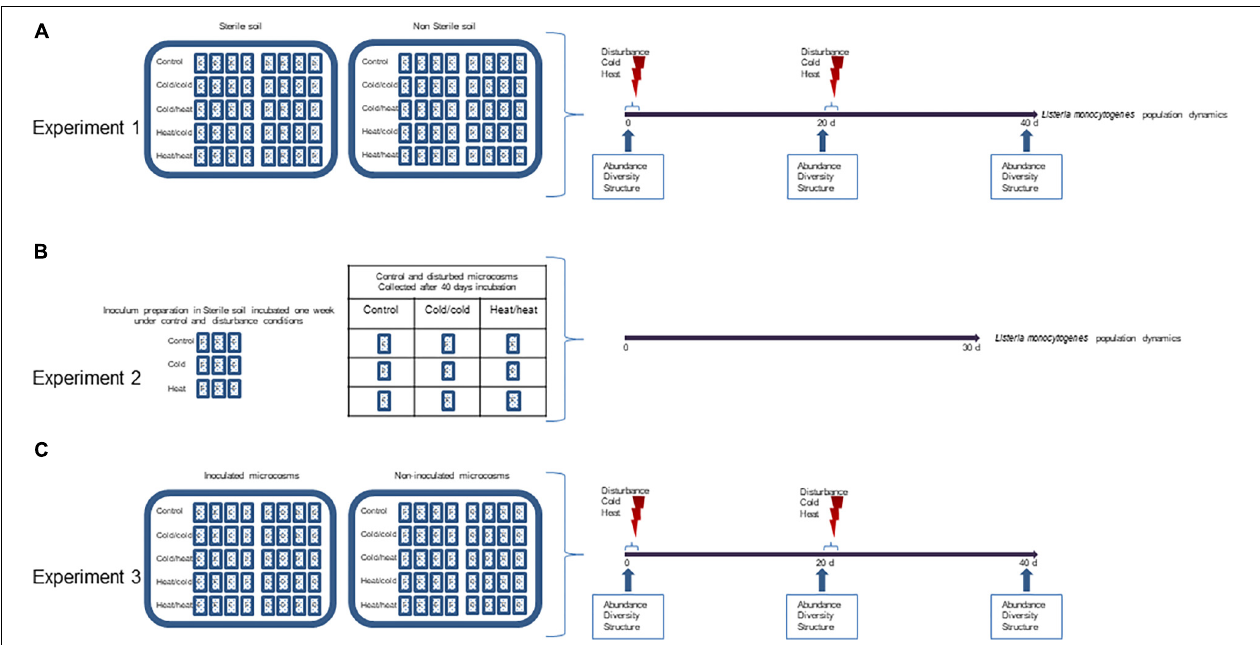
FIGURE 1 | Experimental design. Three sets of experiments were conducted. (A) To test the effect of disturbances on the invasion success, microcosms were prepared with two types of soil E and D, either sterilized by γ -irradiation or non-sterilized; after inoculation, microcosms were incubated for 40 days at 20 ◦ C (control) or submitted to disturbance by shifting the temperature to –20 ◦ C (cold) and/or + 42 ◦ C (heat) at day 0 and day 20; Listeria monocytogenes was enumerated periodically throughout the incubation period. Samples were collected for DNA extraction and diversity analysis at time 0, 20, 40 days. (B) To test the hypothesis that disturbances may prime intrinsic factors facilitating invasion, inoculums were prepared by incubating L. monocytogenes for 1 week in sterile soil undergoing disturbance (cold, heat) or kept undisturbed at 20 ◦ C; 40 days old disturbed or undisturbed microcosms were then seeded with these conditioned soil inoculums. (C) Microcosms were prepared with two types of non-sterile soil E and D; one set of microcosms was inoculation with L. monocytogenes while the other set was kept non-inoculated; microcosms were incubated for 40 days at 20 ◦ C (control) or submitted to disturbance by shifting the temperature either to –20 ◦ C (cold/cold) or + 42 ◦ C (heat/heat) at day 0 and day 20. After DNA extraction, the diversity and community structure of the soil microbiota was analyzed.